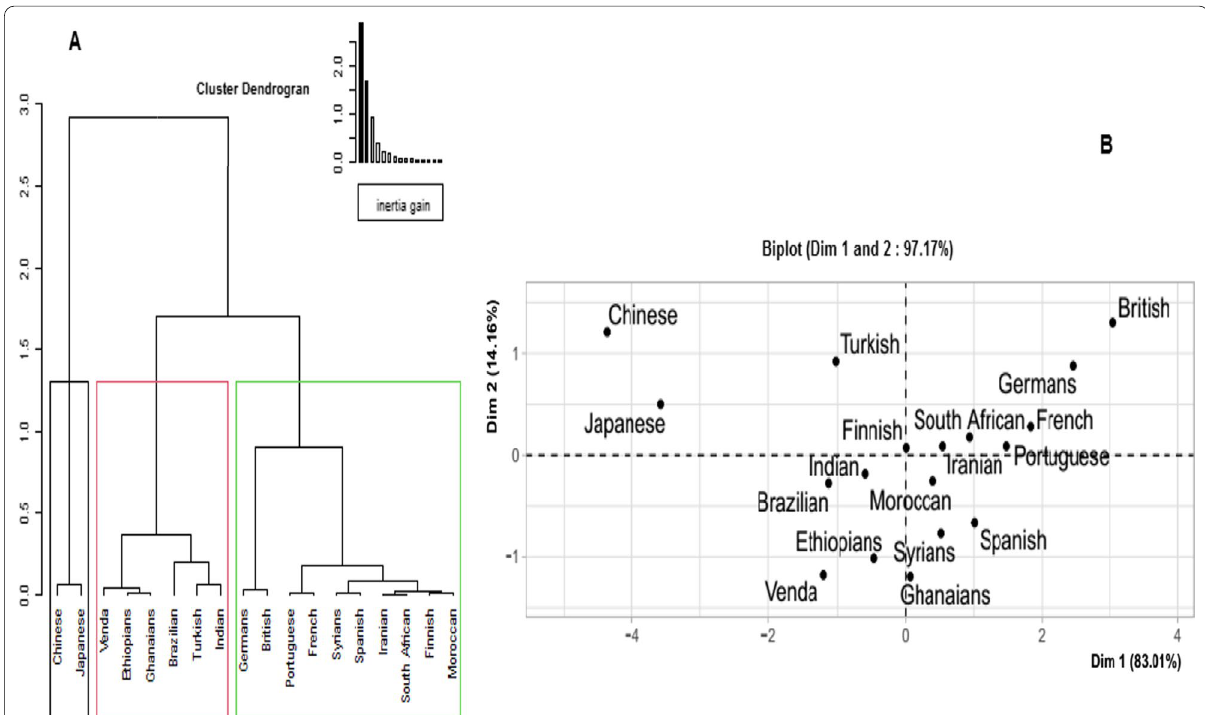
Fig. 3 A Dendrogram cluster showing relatedness between Moroccan population and Mediterranean, African and Asian populations for CYP2D6*4 and CYP2D6*10 alleles. B Principal component analysis of the CYP2D6 allele frequencies distribution on the Mediterranean, South African and Asian